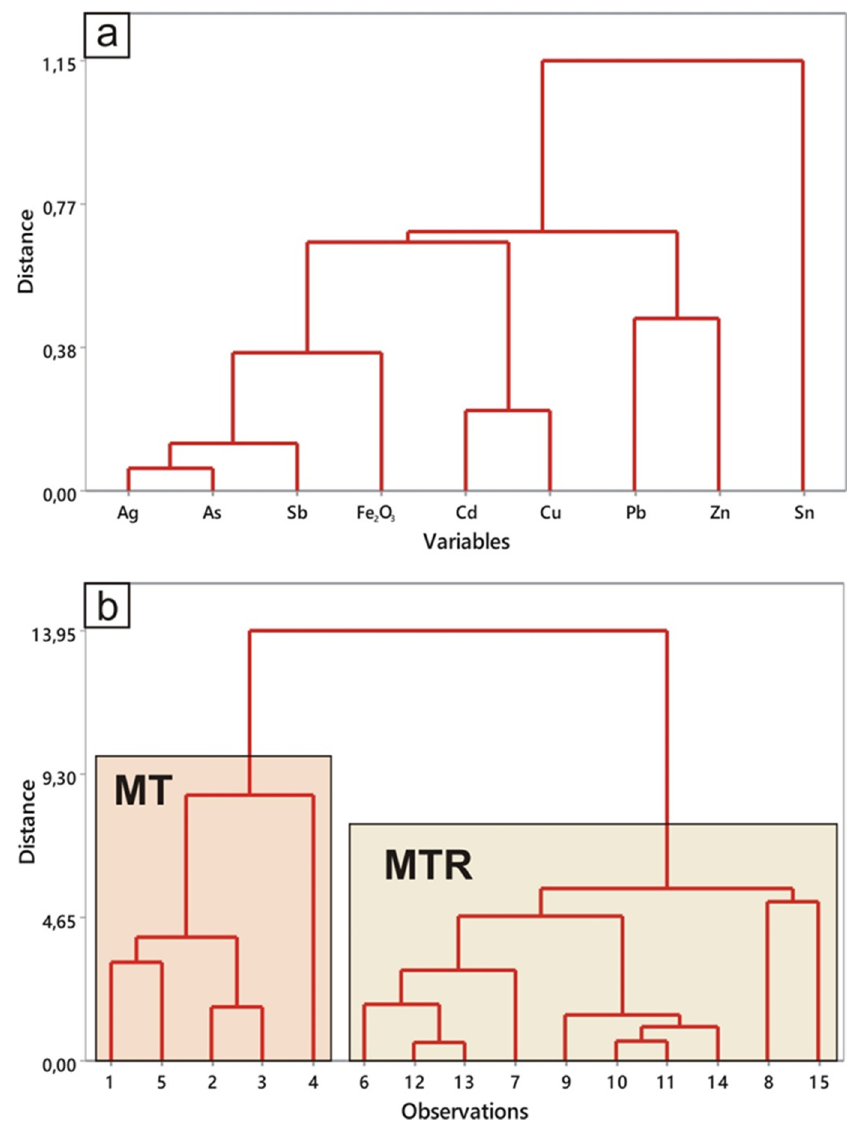
Figure 6. ( a ) Dendrogram (distance: simple) of metals from all borehole samples; ( b ) dendrogram (distance: Euclidean) defining two main associations of samples: mine tailings (MT) and mine tailings mixed with riverbed deposits (MTR).